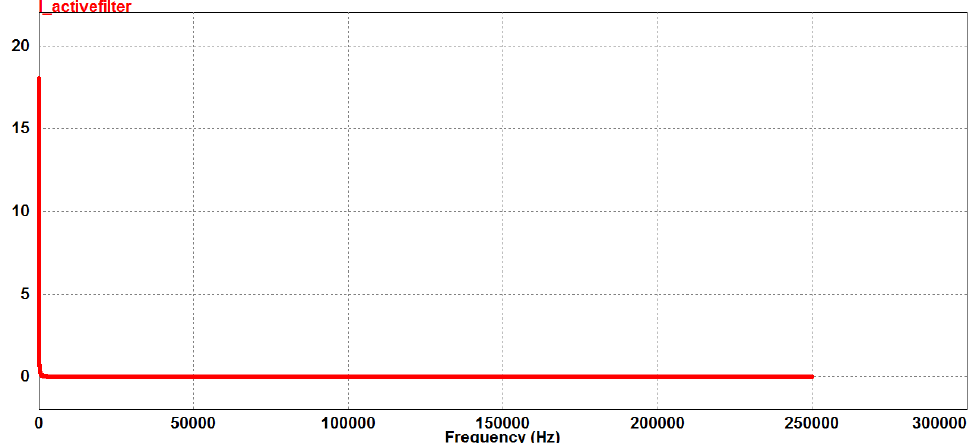
Figure 4(b). Input current FFT analysis of the IHE after installation of